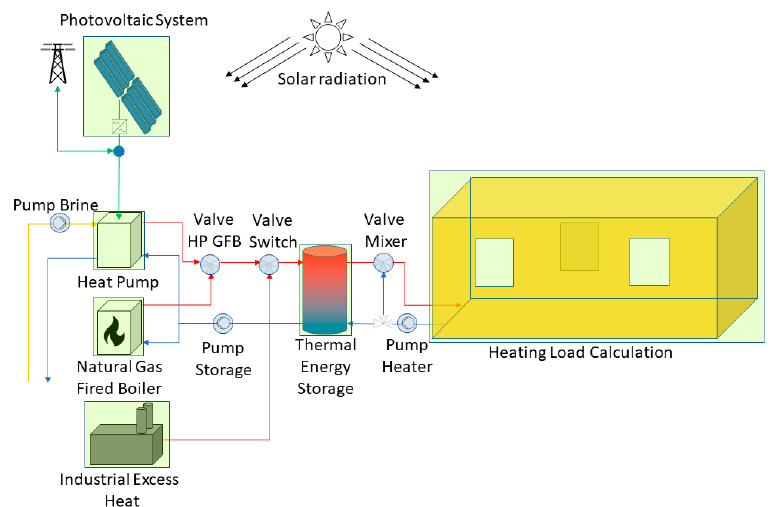
Figure 3. Heating curve based on pre-defined support points.